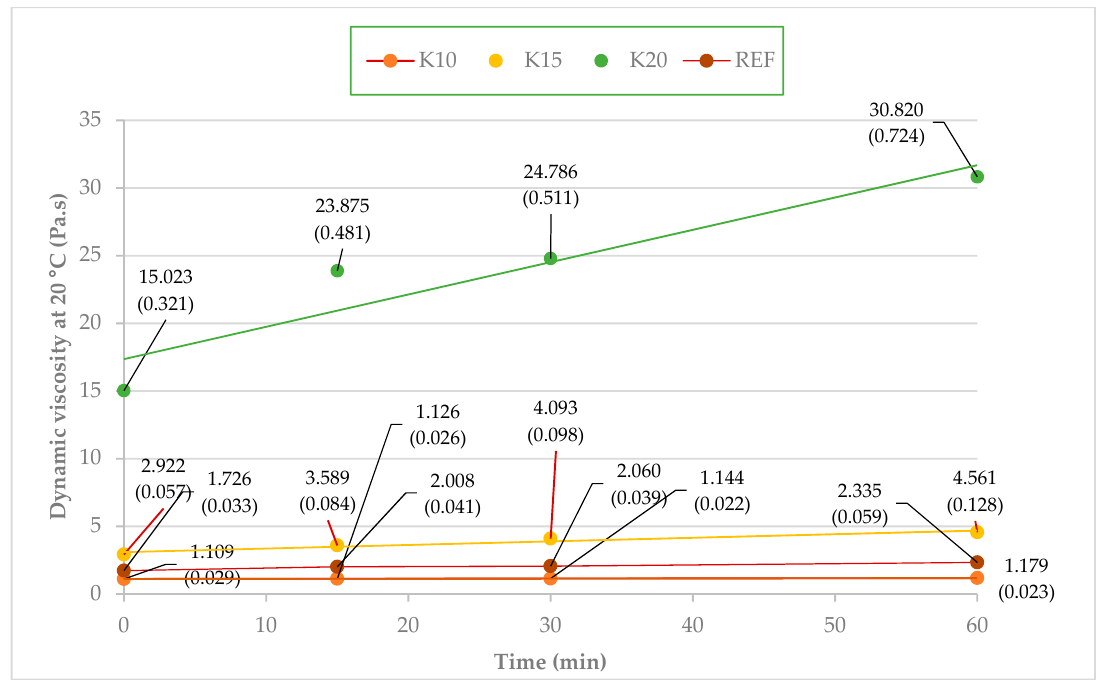
Figure 3. Time-viscosity dependence at 20 °C for the adhesive mixtures REF, K10, K15, and K20 (values in parenthesis are standard deviations).